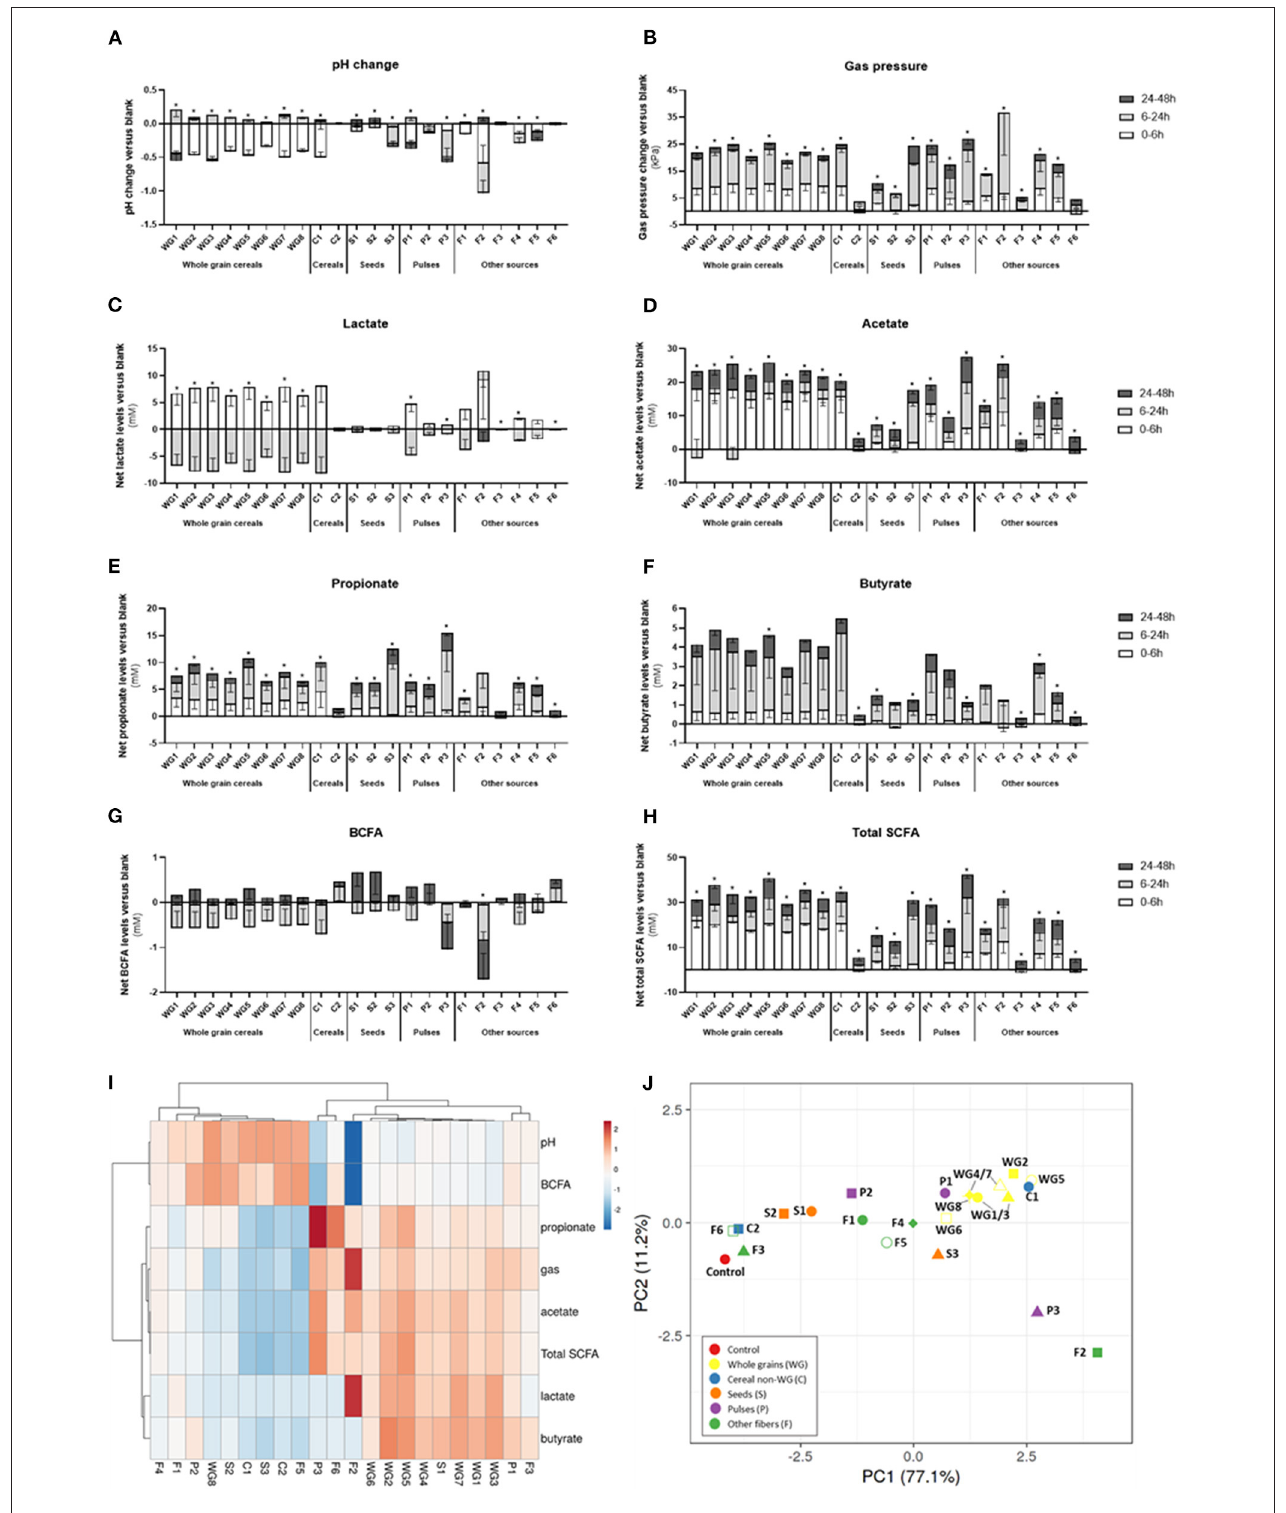
FIGURE 4 | Effect of dietary fibers on microbial activity. Bars represent the net values of pH (A) , gas pressure (B) , lactate (C) , acetate (D) , propionate (E) , butyrate (F) , branched-chain fatty acids (G) , and total short-chain fatty acids (H) , normalized vs. control levels (average ± SD n = 3 donors; three technical replicates for